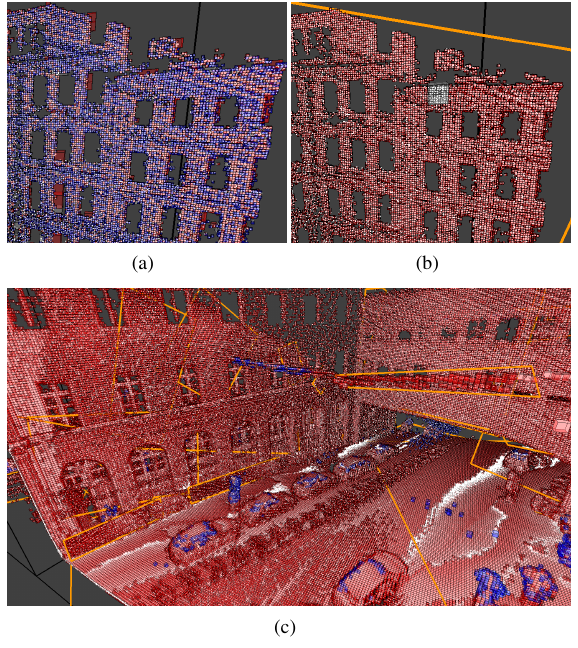
Figure 5. The volumetric representation (a) without and (b,c) with plane-filtered raycasting (red=solid, blue=moving